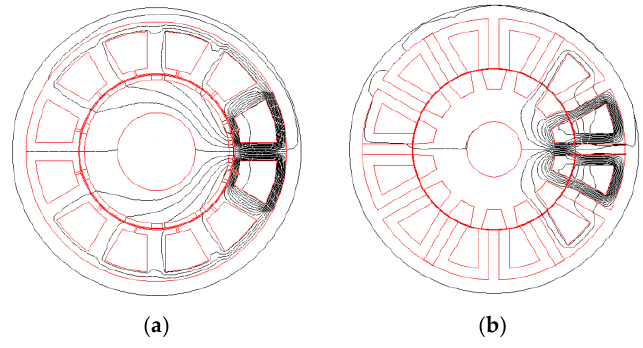
Figure 3. Armature field distribution: ( a ) FTRPM machine; ( b ) FTFSPM machine.